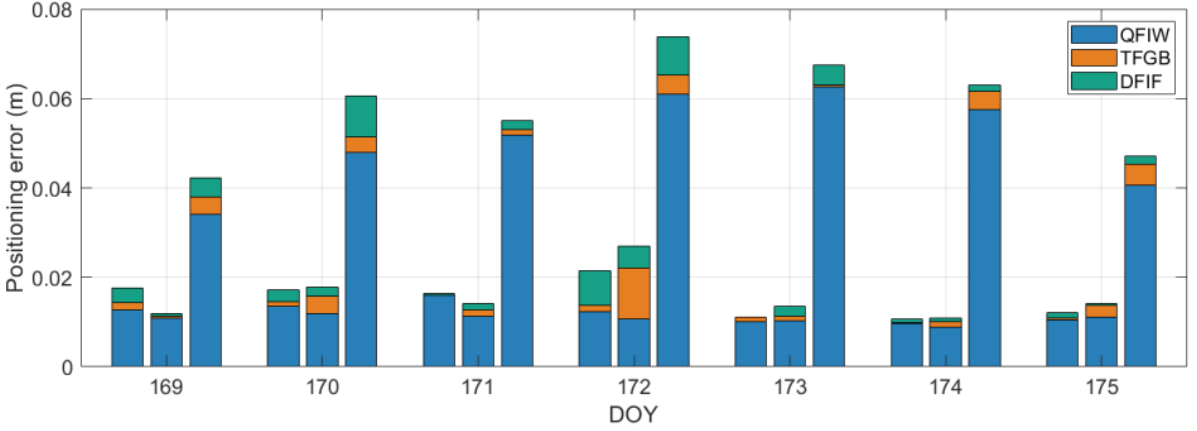
Figure 13. User positioning error of seven days under three models.